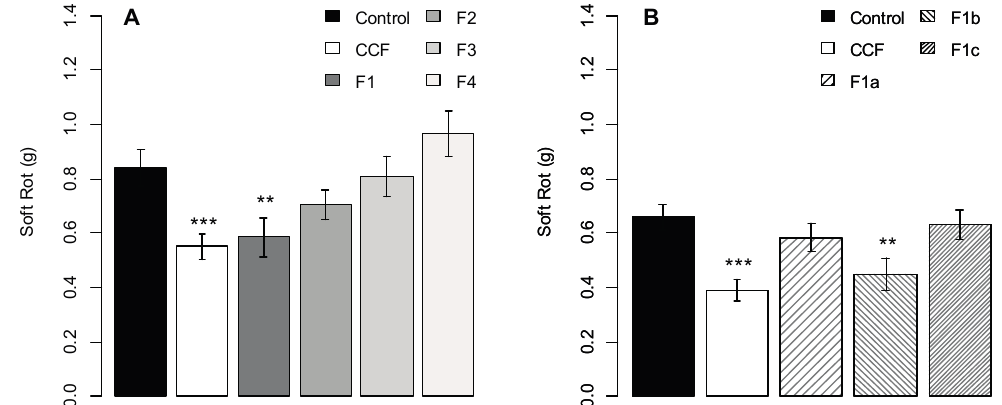
Figure 4. Protection activity of fractionated CCF ( A ) and of F1 sub-fractions ( B ) on potato tubers slices against Pectobacterium atrosepticum . Values are means of replicates of three independent experiments ± standard error. Bars with different stars subscripts are significantly different from the water control (Tukey HSD, *** p = 0.001, ** p =